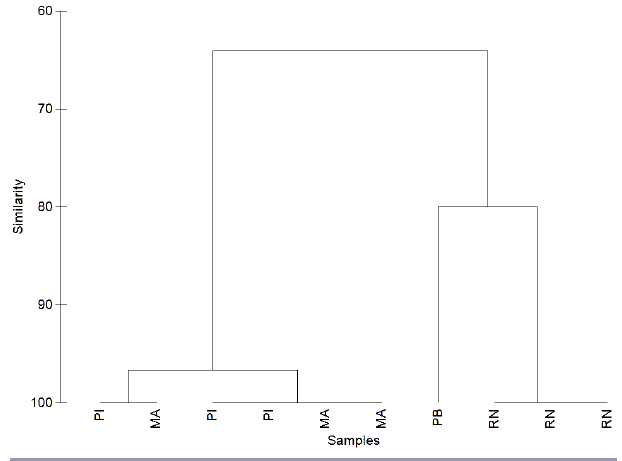
Fig. 3 . Dendrogram of similarity (Jaccard index) produced by cluster analysis (UPGMA connection method) among the 10 municipalities surveyed of Caatinga